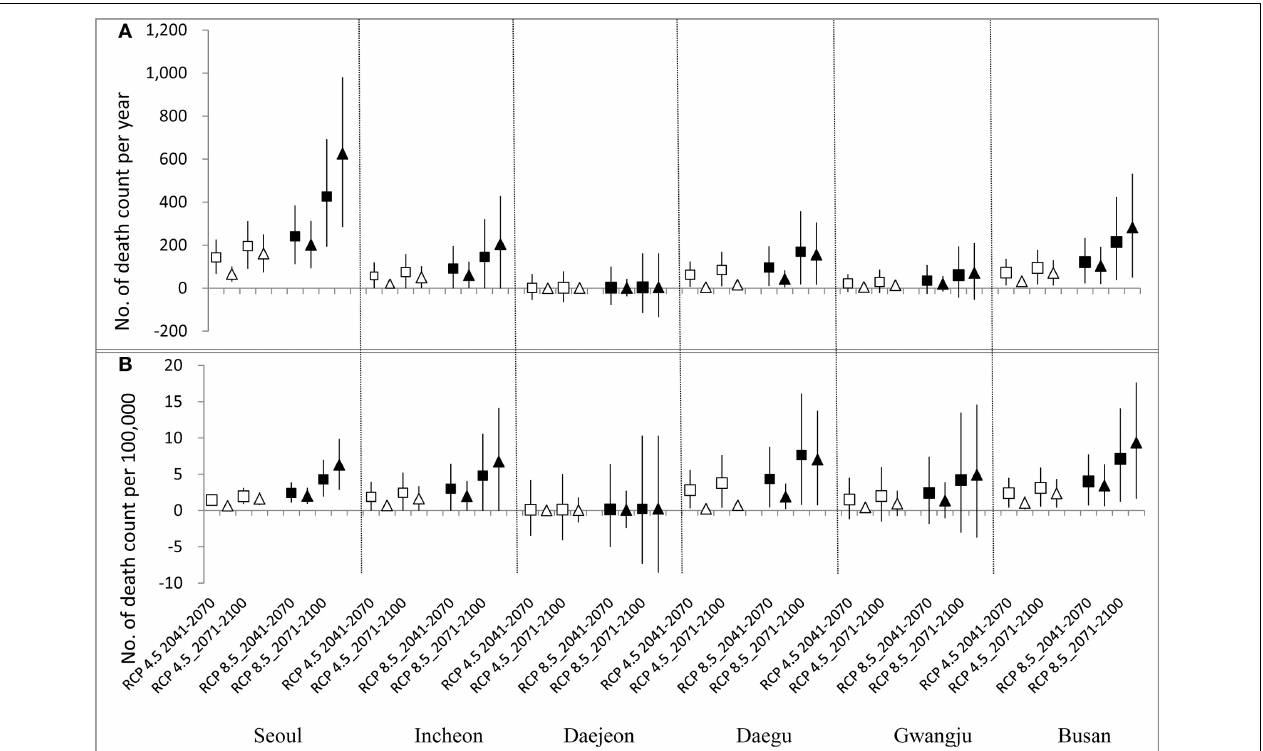
FIGURE 3 | Heat-related mortality attributable to climate change under RCP 4.5 and RCP 8.5. Top graph (A) presents absolute values of death count and bottom one (B) presents values of death count with adjustment of projected future population scale. (White square and